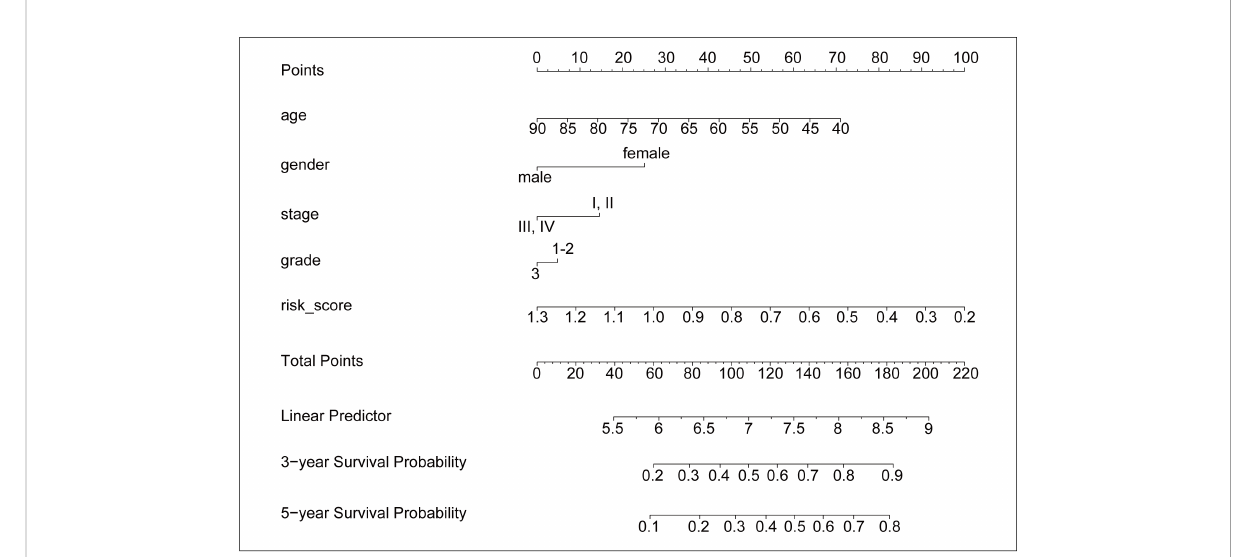
FIGURE 6 The nomogram for predicting the 3-year and 5-year survival probability of GC. The nomogram model was constructed in training dataset, with the age, gender, stage, grade, and risk score of six ALKBH5-related risk